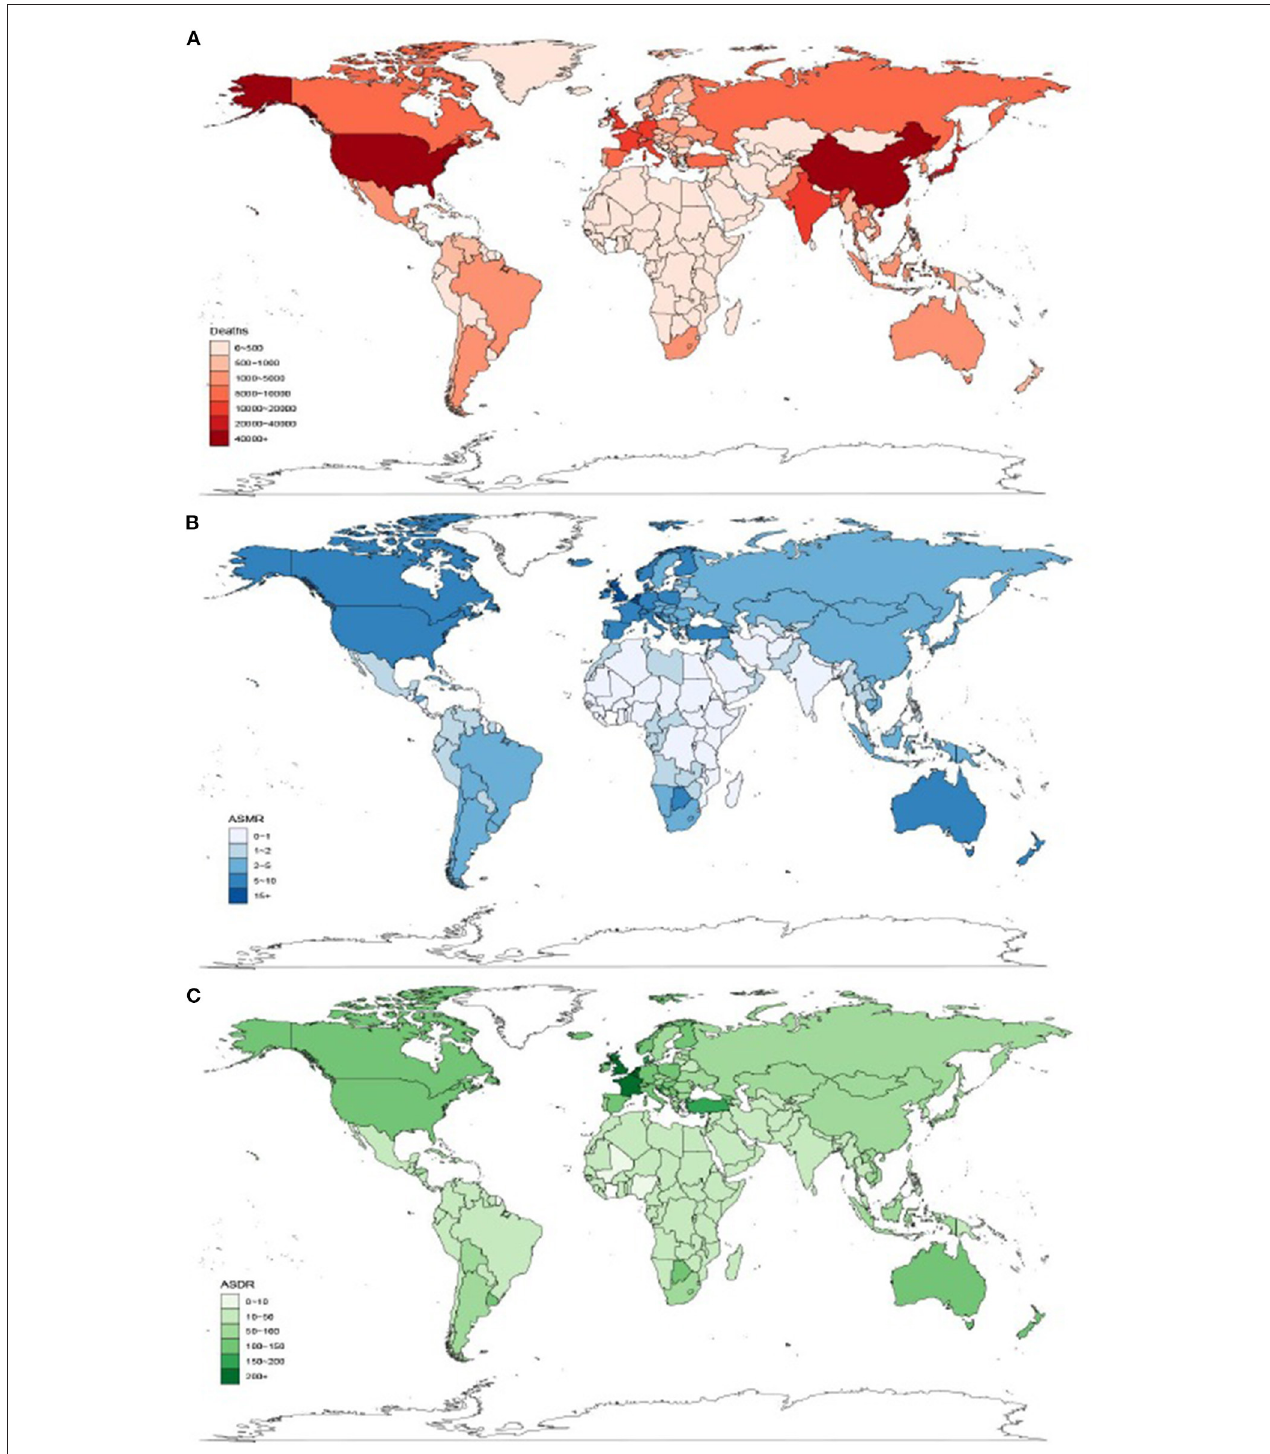
FIGURE 2 | Global distribution of occupational carcinogen–attributable TBL cancer burden in terms of deaths (A) , ASMR (B) , and ASDR (C) in 2019. TBL cancer, tracheal, bronchus and lung cancer; ASMR, age-standardized mortality rate; ASDR, age-standardized DALY rate. for global data and from countries with different SDI values tool). Of 87 risk factors, nine OCs were analyzed between 1990 and 2019 (http://ghdx.healthdata.org/gbd-results-